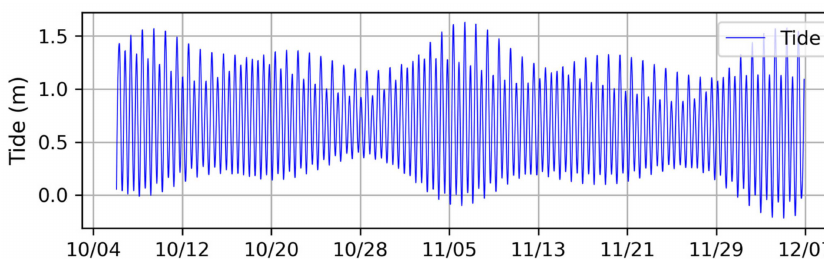
Figure 2. Tide cycle during the experiment.